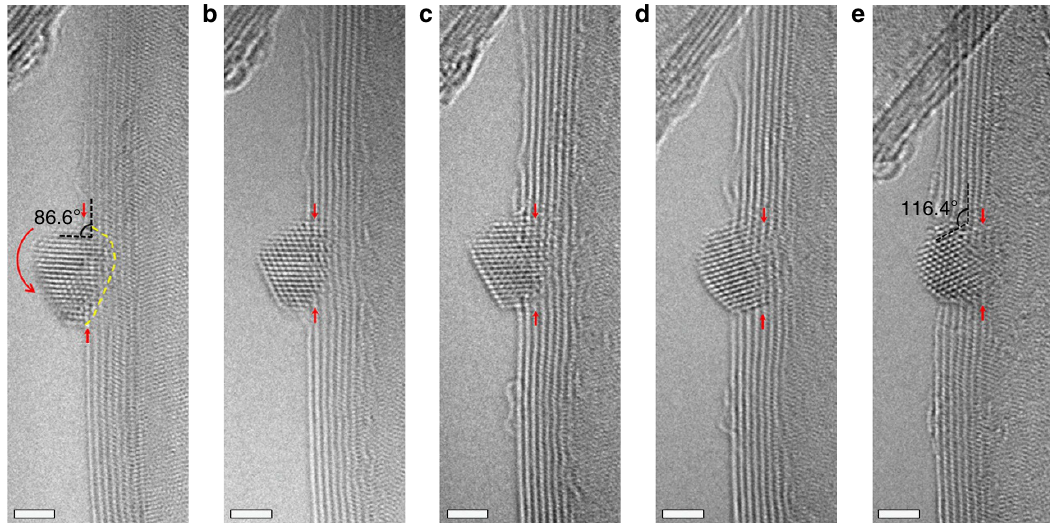
Figure 2 | A series of high-quality AC-ETEM images during the oxidation process. The oxidation reaction was conducted at 250 (cid:2) C in 2mbar O 2 with different oxidation times: ( a ) 0s; ( b ) 300s; ( c ) 600s; ( d ) 900s; and ( e ) 1,800s. Scale bars, 2nm. The two dashed black lines in a mark the angle between the Ag NP/MW-CNT system, which was used to monitor the rotation of the Ag NP. The curved red arrow denotes the rotation direction and the yellow dashed line marks the contact interface between the Ag NP and the